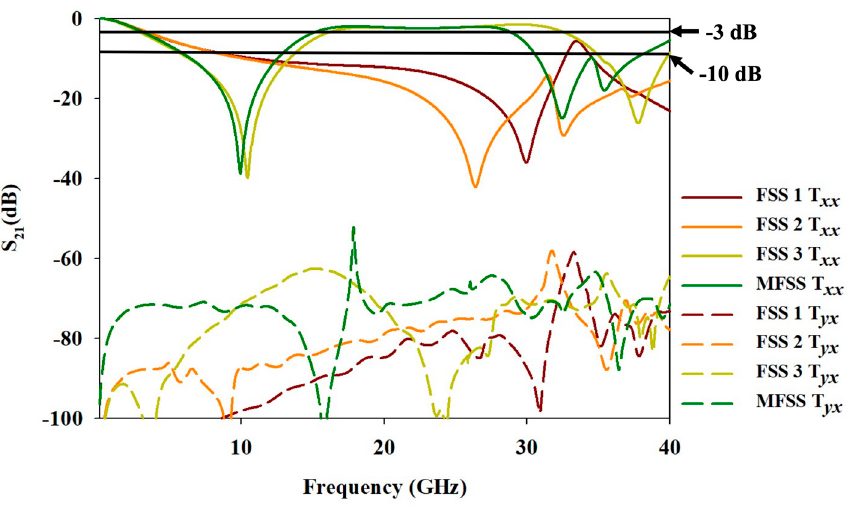
Figure 3. The simulated S (cid:2870)(cid:2869) from the evolution of MFSS unit cell. When the unit cell evolved to FSS 3, the simulated T (cid:3051)(cid:3051) frequency response exhibited bandstop responses at low ‐ and high ‐ frequency bands with a bandpass frequency re ‐ sponse, which is generally portrayed by the combination of the patch and slot geometry [6].